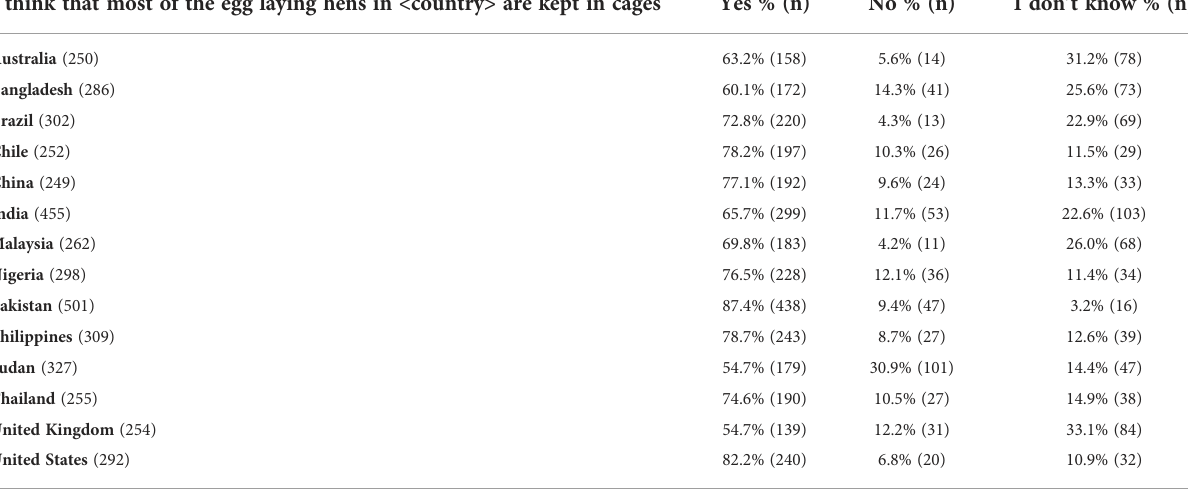
TABLE 2 Percentage of respondents who believe most egg laying hens are kept in cages, by country. I think that most of the egg laying hens in <country> are kept in cages